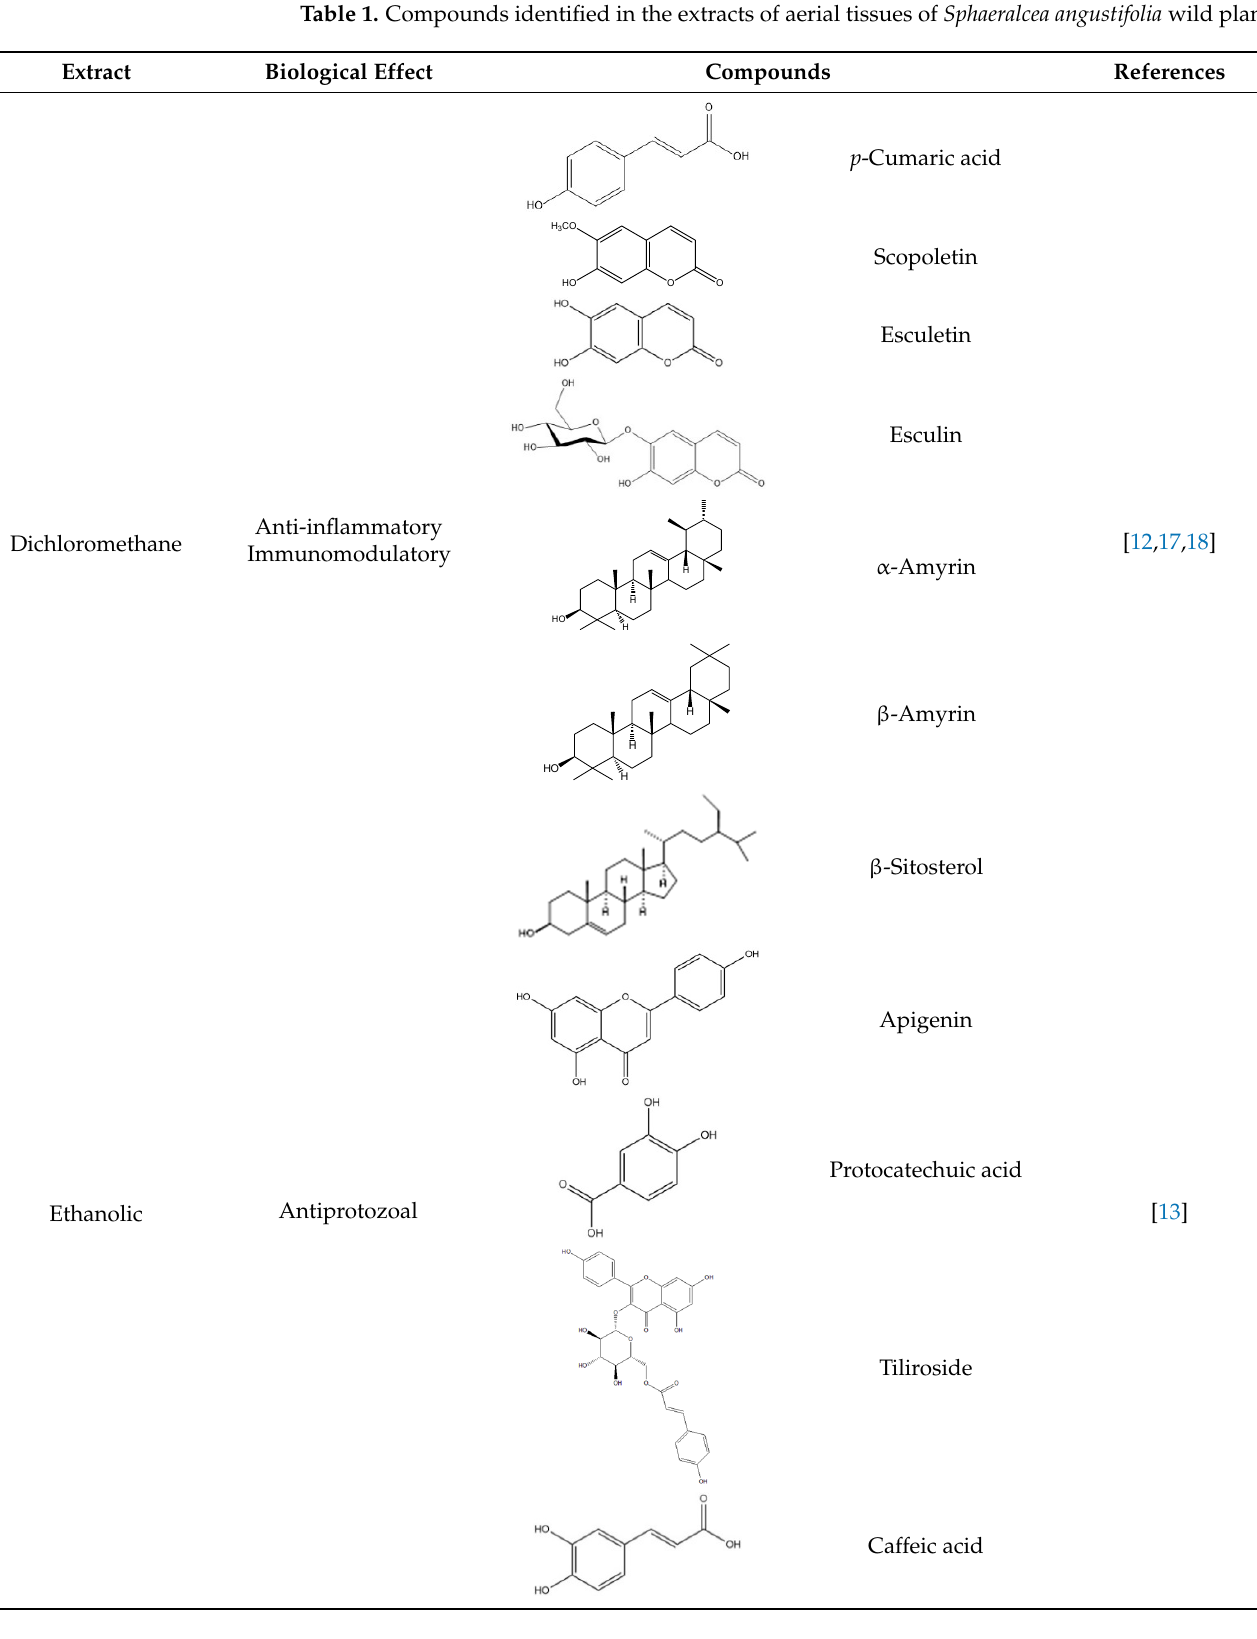
Table 1. Compounds identified in the extracts of aerial tissues of Sphaeralcea angustifolia wild plant.